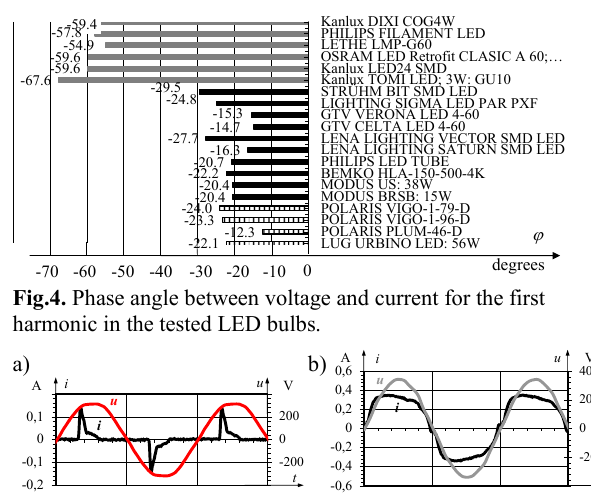
Fig.3. Percentage of higher current harmonics and THD I drawn from a low-voltage power grid by road LED lights.